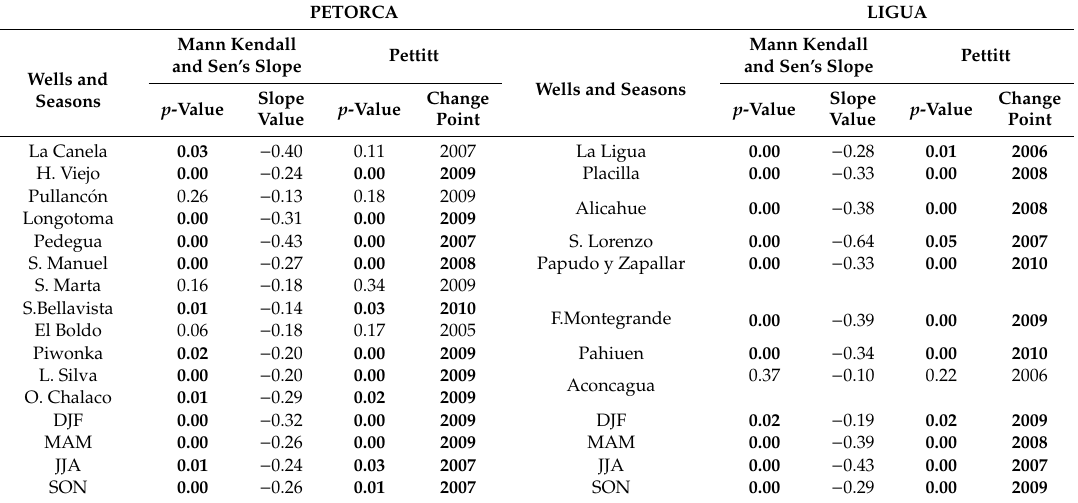
Table 5. Trend analyses of annual average GW by well and season during 2002–2017. PETORCA LIGUA Mann Kendall Mann Kendall Pettitt and Sen’s Slope and Sen’s Slope Wells and Wells and Seasons Seasons